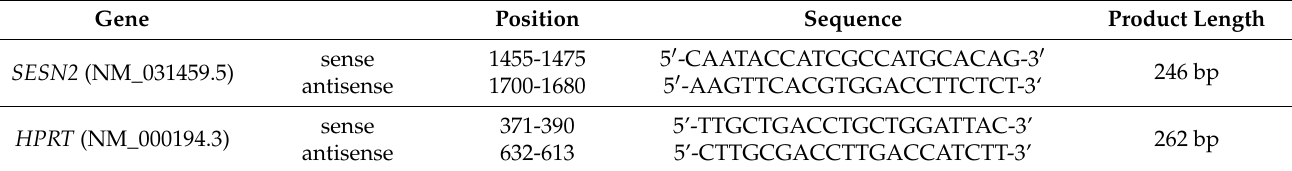
Table 2. PCR primer